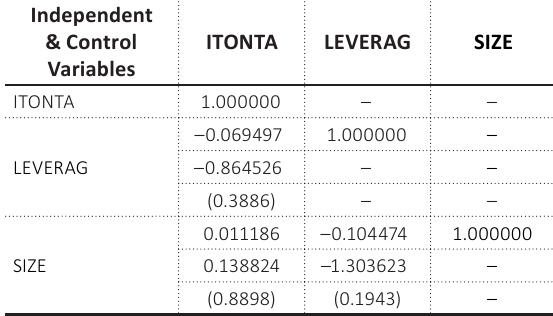
Table 5. Pearson correlation between